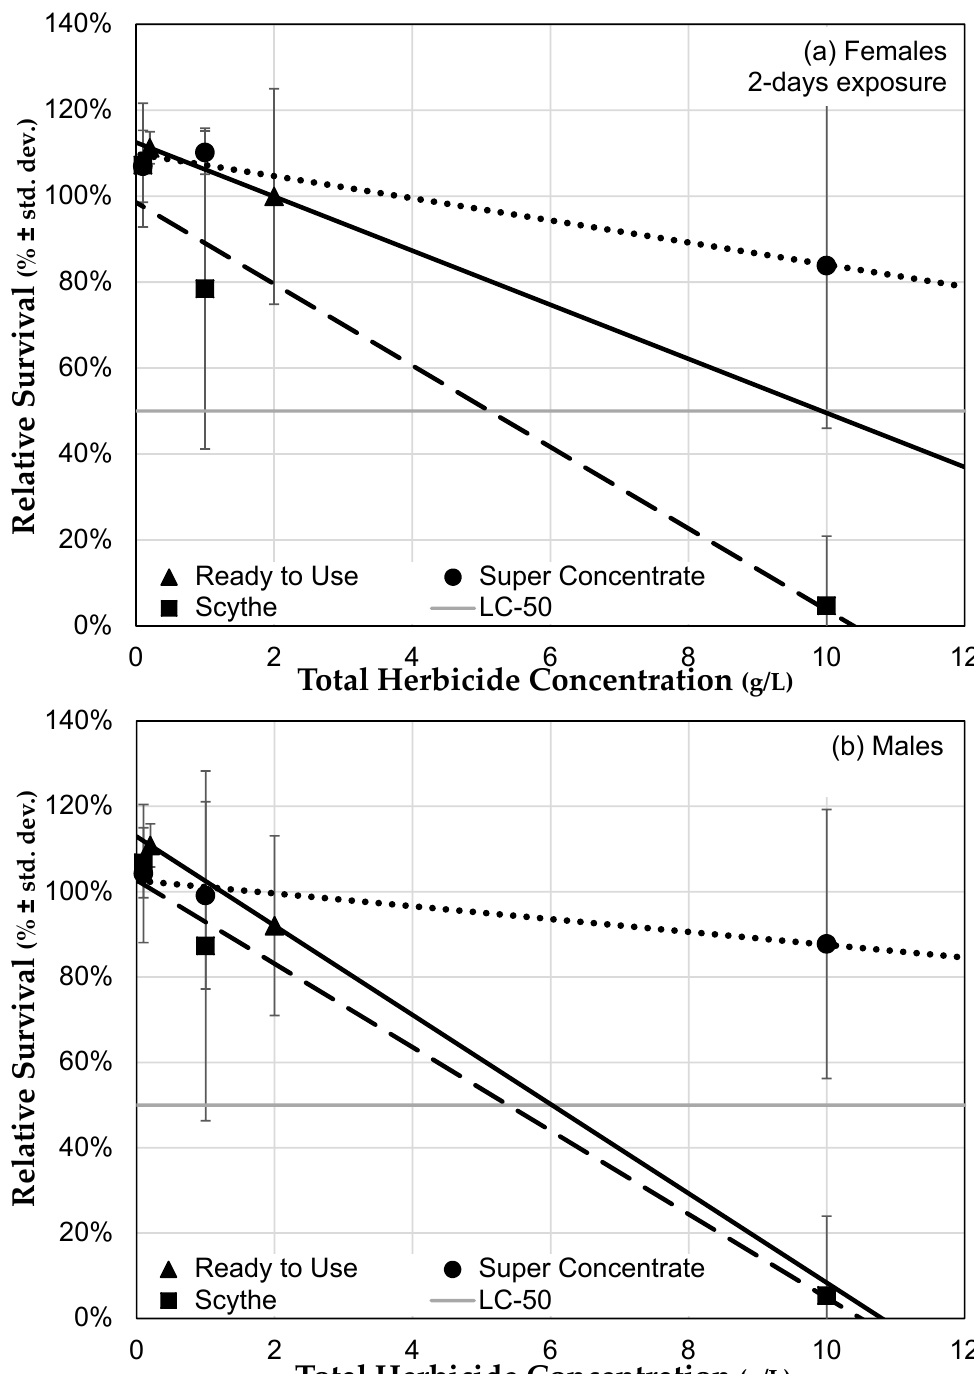
Figure 6. Effect comparison of the effects of three herbicide formulations on relative survival. Survival of ( a ) females and ( b ) males after two days of herbicide exposure (nine days post eclosion) to three herbicide formulations in food medium, compared to the survival of flies of the same age and sex exposed to control medium (± std. dev.). The light grey line indicates 50% survival and can be used to determine LC 50 for some formulations.